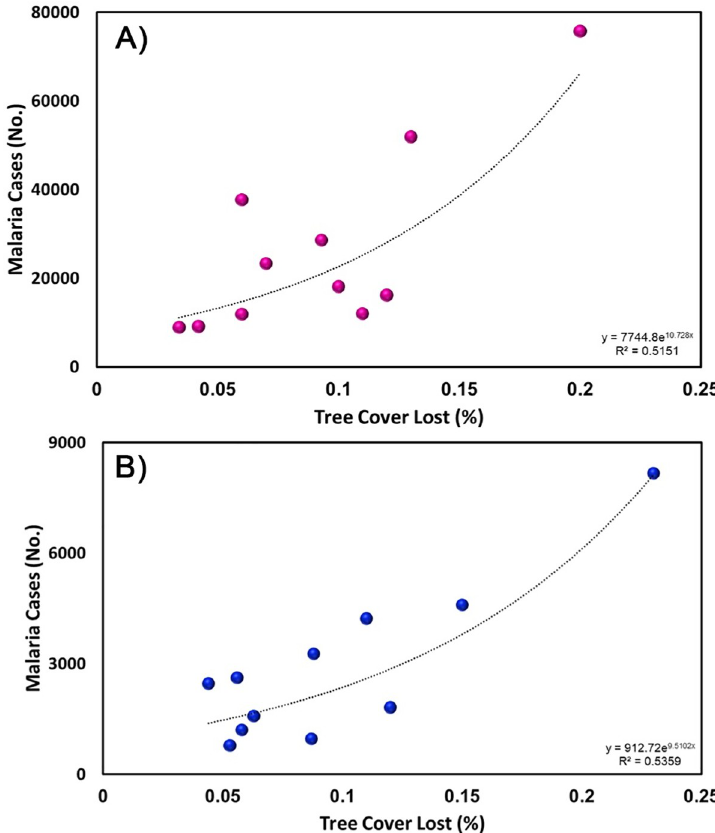
Fig 6. Percentage of deforestation (tree cover lost) and accumulated malaria ( P . vivax + P . falciparum cases) in Sifontes Municipality (A) and Gran Sabana Municipality (B) in Bolı´var State.